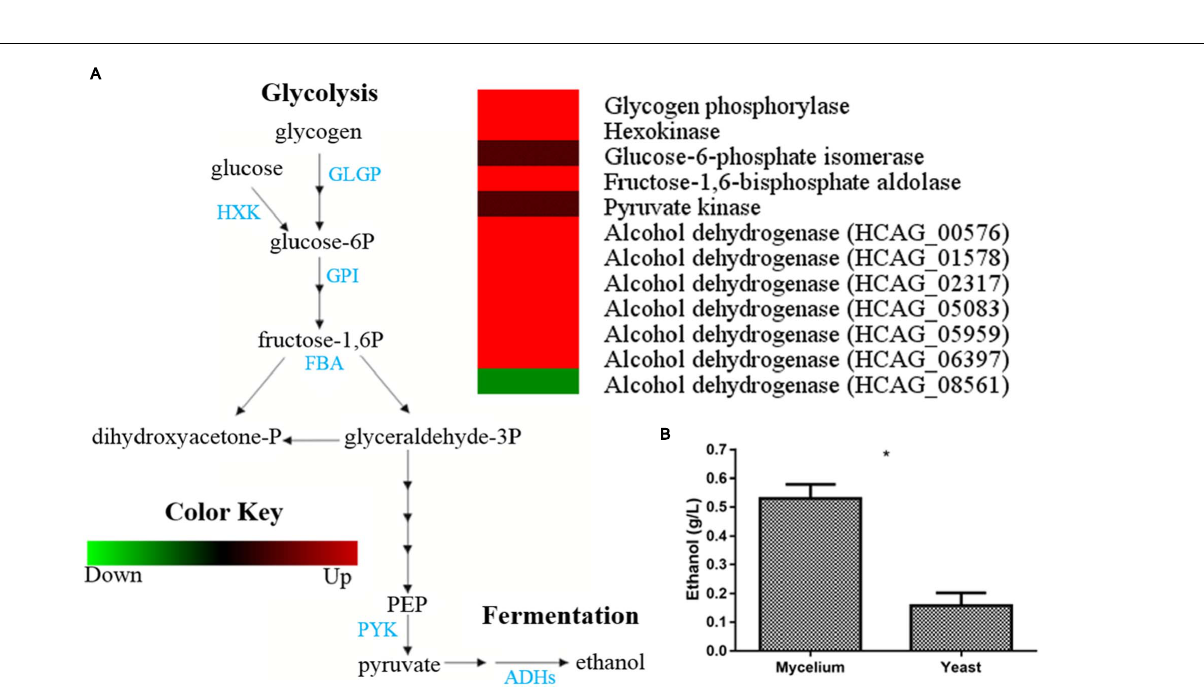
Frontiers in Microbiology |